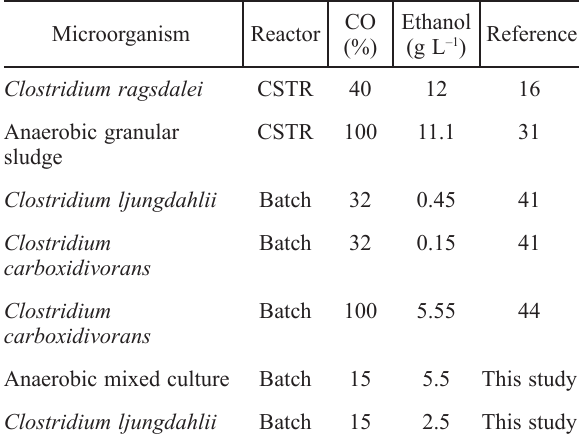
Table 3 – Comparison of the results with literature (syngas fermentation) Microorganism Reactor